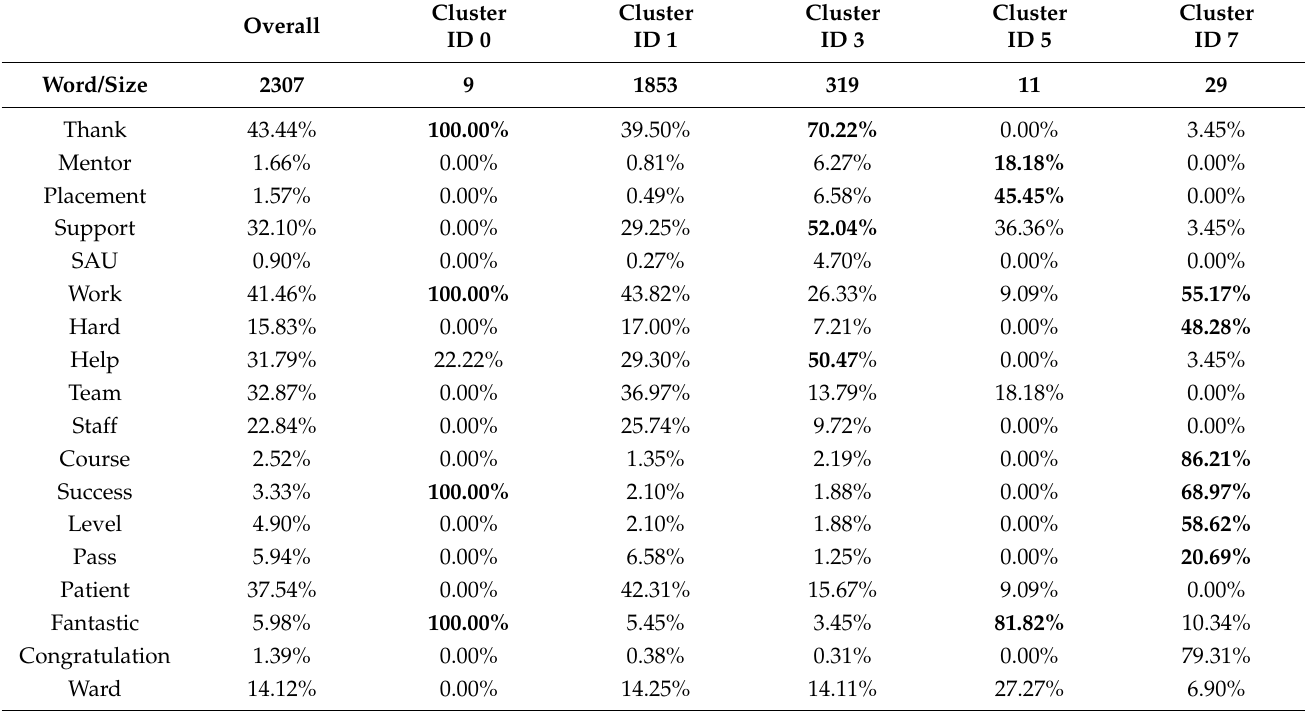
Table 8. The percentage of times words appeared in each text item, in each cluster, when k = 8. Only the five largest clusters are shown, since the other three clusters only contained a single item each. Bold values represent statistically significantly values ( p < 0.5) in a given cluster when compared to their occurrence in the entire dataset. The case (upper or lower) of the words was not considered.